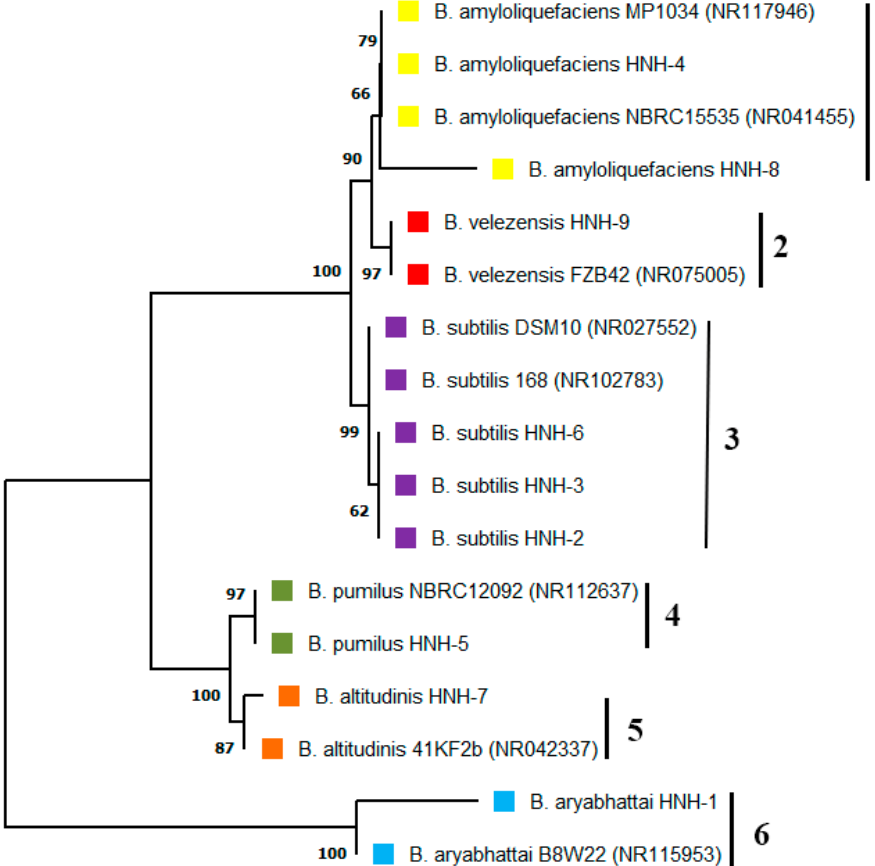
Figure 1. Phylogenetic studies of endophytic Bacillus strains isolated from cotton roots. The optimal neighbor joining tree indicating that the bacterial endophytes fall into six different clusters. The numbers added with each branch indicate the species, where 1 = B. amyloliquefaciens , 2 = B. aryabhattai . Table 1. Mycelial inhibition by endophytic Bacillus strains.